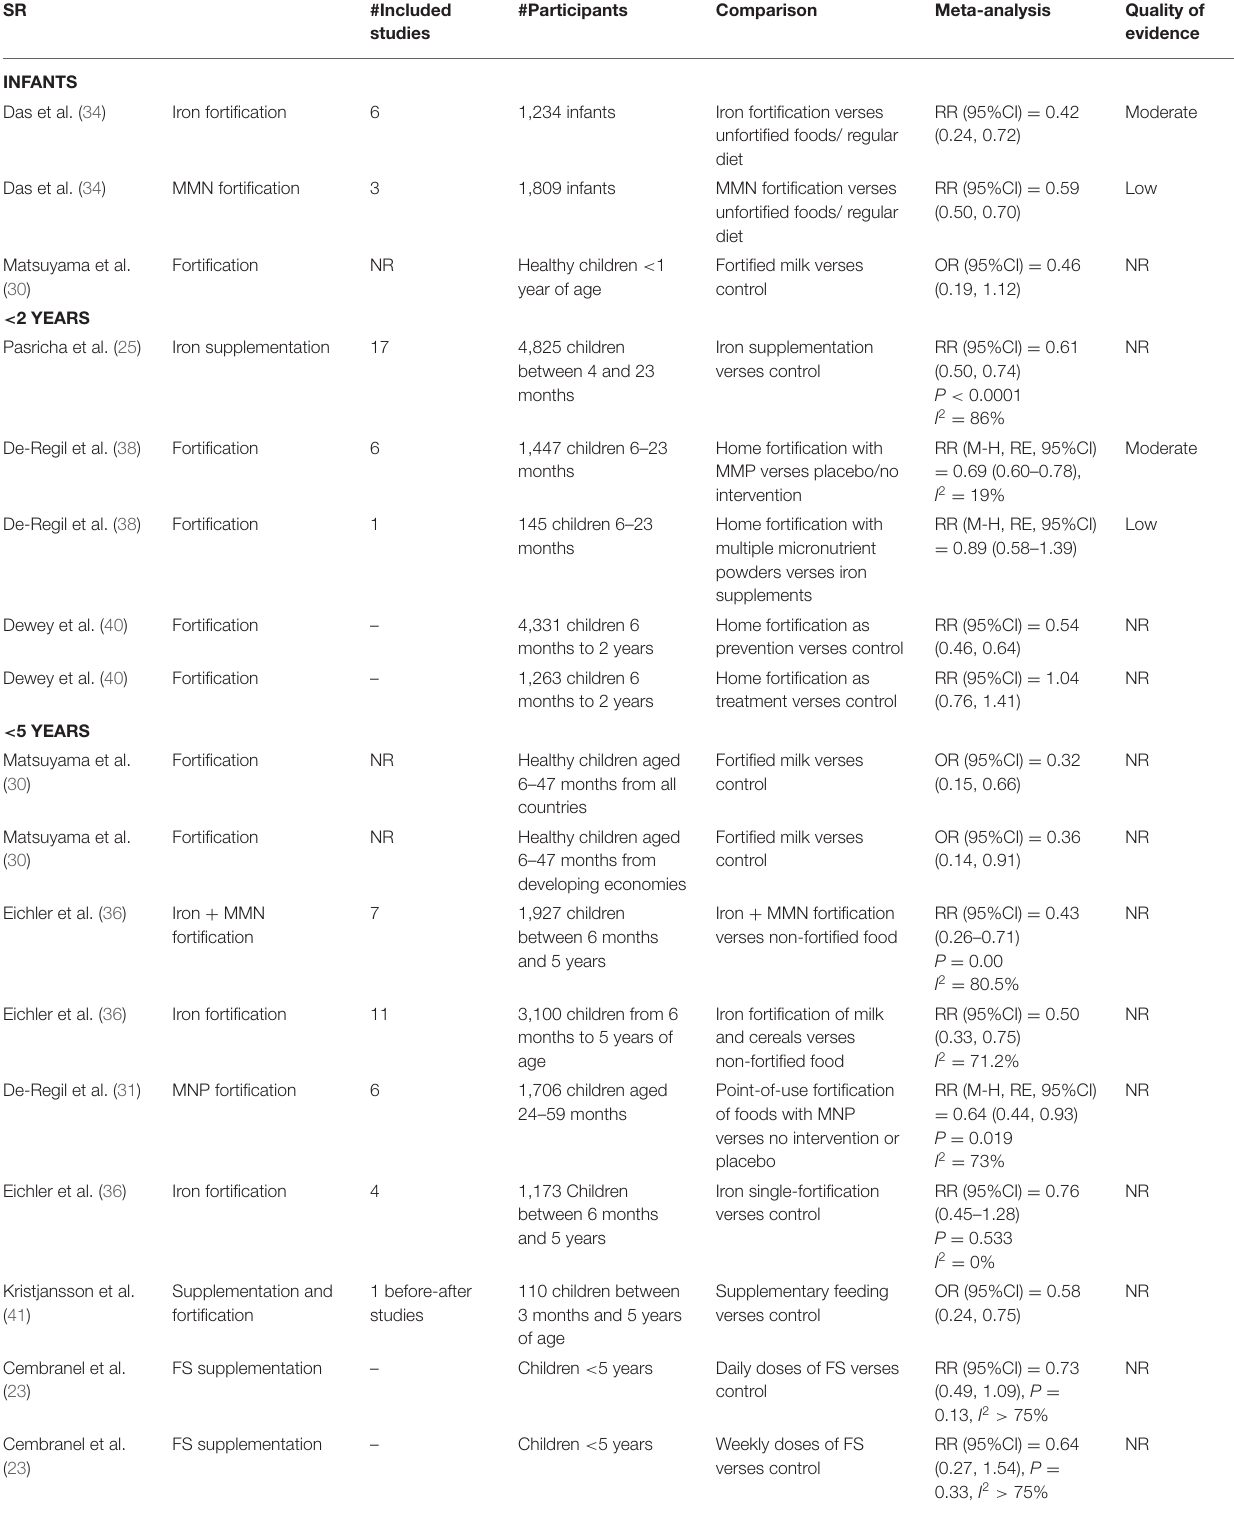
TABLE 2 | Findings for anemia in included systematic